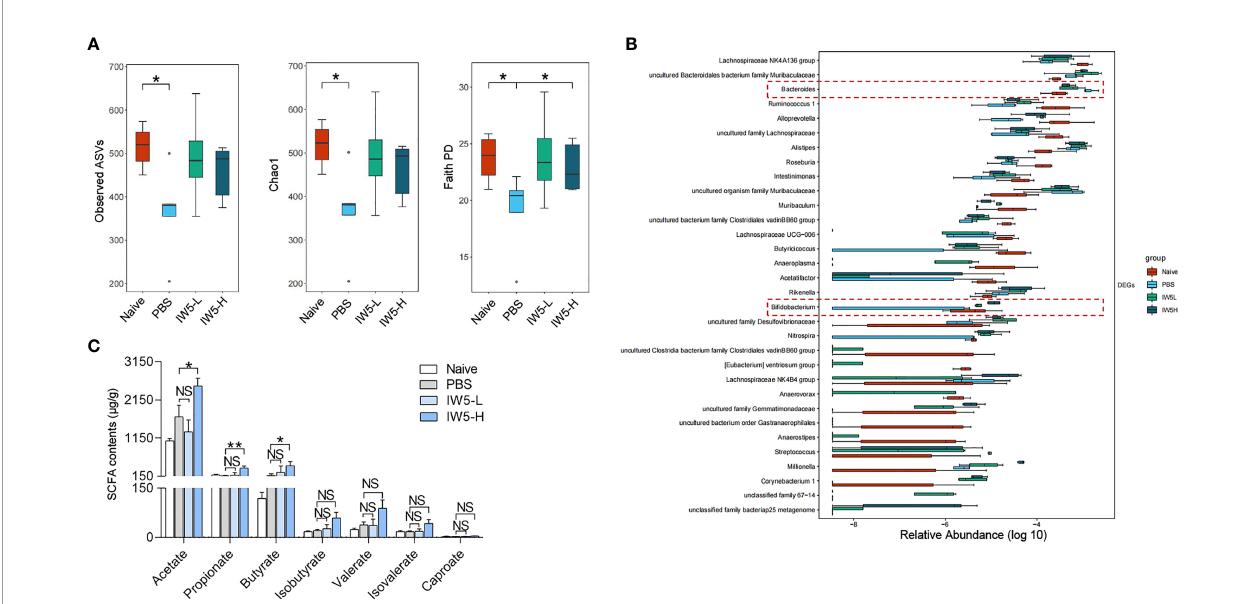
FIGURE 4 | IW5 modulates fecal microbiota composition and SCFAs production. Mice feces were collected from the MC903-induced AD model before and after IW5 treatment. (A) Alpha-diversity of the gut microbiota as indicated by the observed ASVs, chao1 index, and faith pd index. (B) Relative abundance of the gut microbiota at the genus level. (C) Contents of acetate, propionate, butyrate, isobutyrate, valerate, isovalerate, and caproate in fecal samples. Data are shown as means ± SEMs, and representative of data from three independent experiments. Student ’ s t-test for parameters, and Mann-Whitney test for nonparametric data.